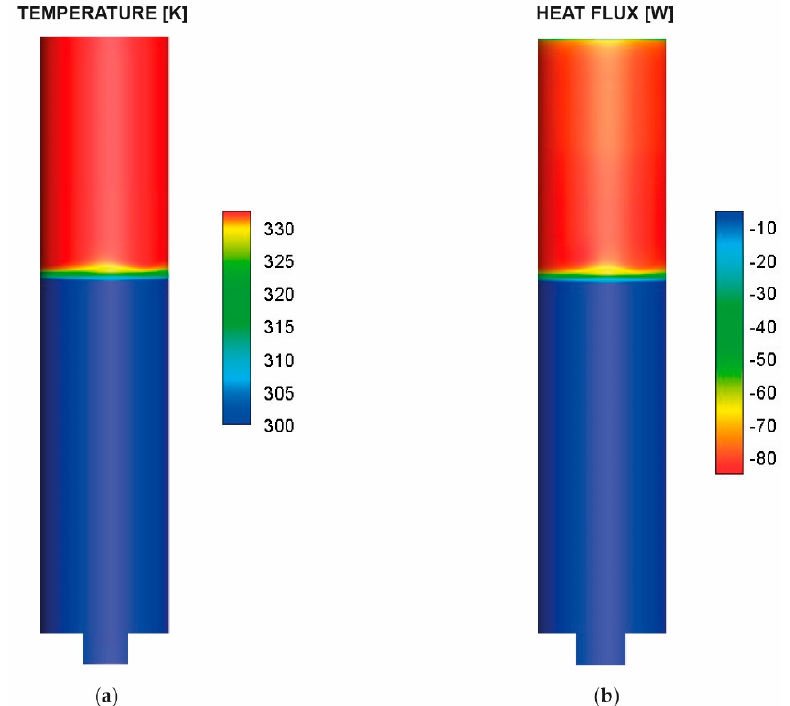
Figure 13. Thermodynamic analysis considering a guide vanes closure process of 1 s. ( a ) Maximum value of temperature in water and air; and, ( b ) Heat transfer trough the walls of the closed surge tank in water and air.